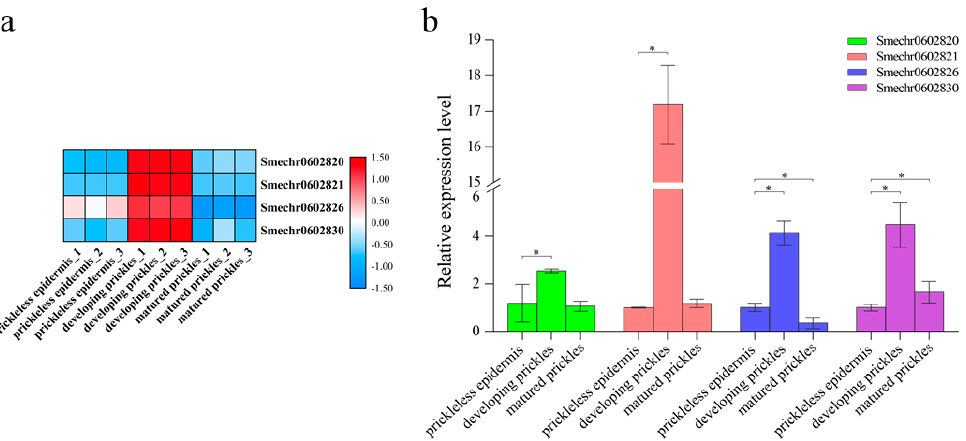
Figure 6. Heatmap analysis and qRT-PCR validation of the DEGs within the Pl locus interval. ( a ) Heatmap showing the expression patterns of the DEGs within the Pl locus interval. The heatmap was generated based on the normalized log 2 (TPM+1) values for each DEG. Blue and red scales represent relatively low or high expression, respectively. ( b ) qRT-PCR validation of the DEGs within the Pl locus interval. The results were expressed as mean ± SD, * for p -value < 0.05.